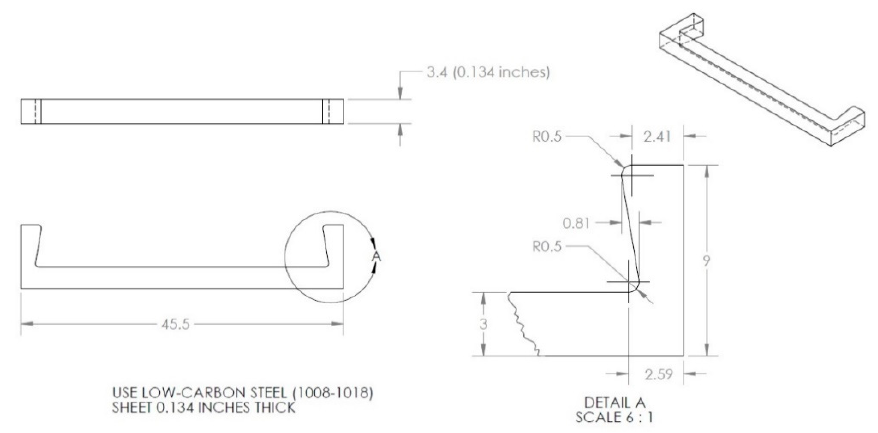
Figure 5. Sacrificial steel specimen, made from the same oil and gas pipeline material.